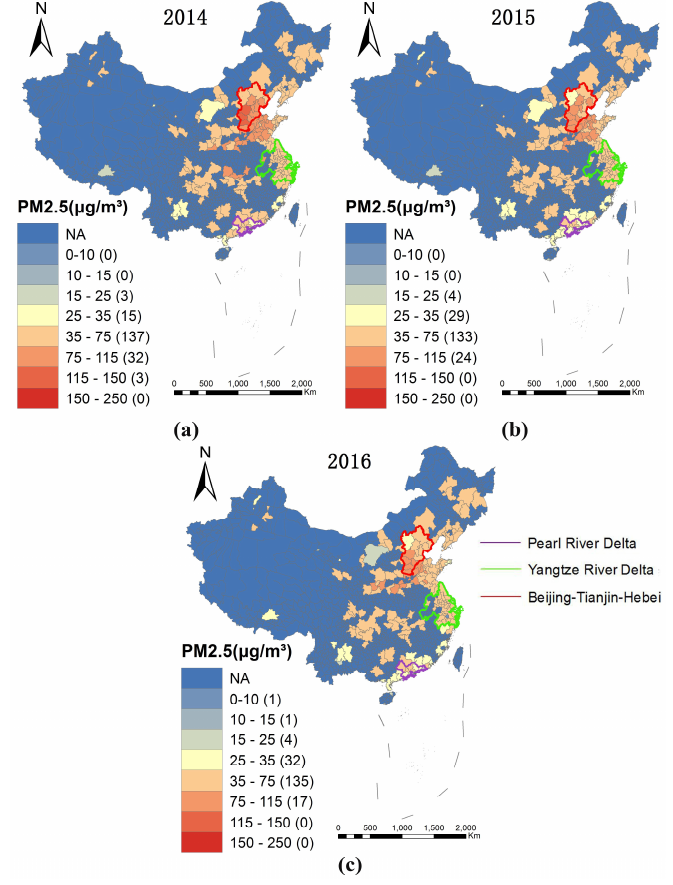
Figure 1. Spatial distribution of PM 2.5 in 2014 ( a ); 2015 ( b ); and 2016 ( c ).